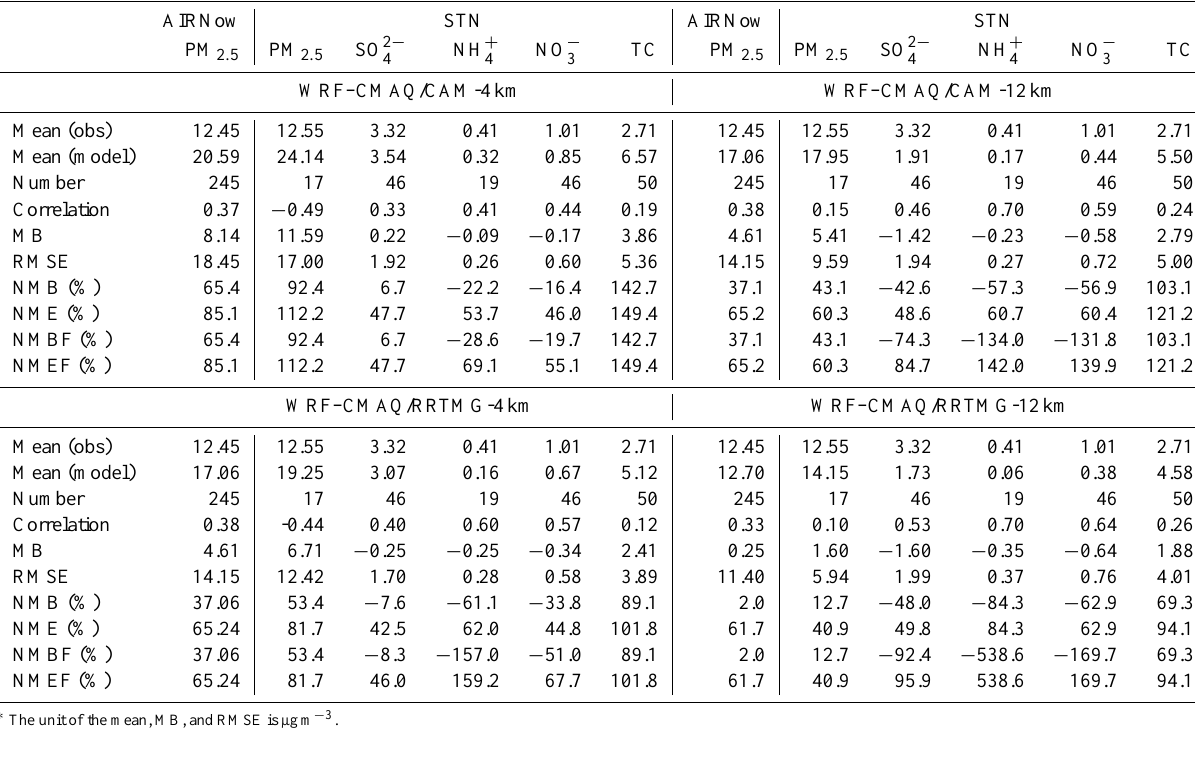
Table 6. Comparison of observation and models (WRF–CMAQ/CAM and WRF–CMAQ/RRTMG) for PM 2 . 5 and its components for each network over the eastern Texas domain from the simulations of the 4 and 12km resolution model grids for August of 2006 ∗ .